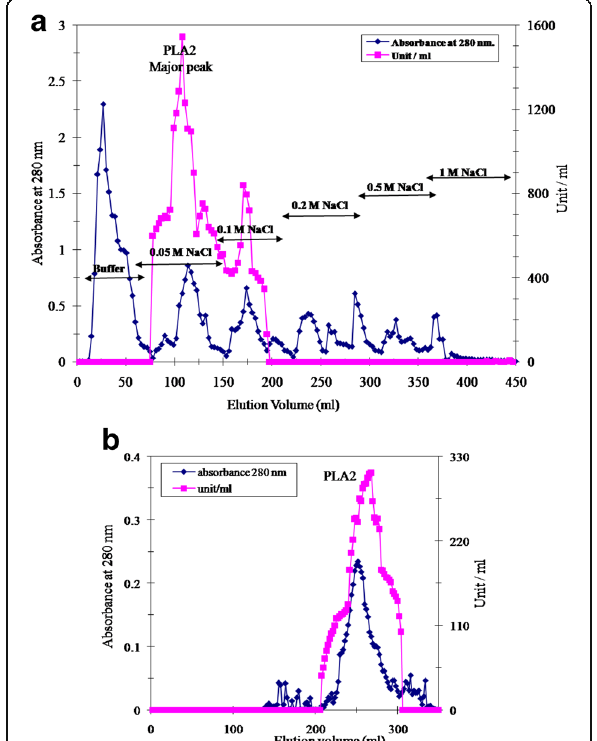
Fig. 1 a DEAE-cellulose column chromatography elution profile of crude honey bee venom. b Sephacryl S-300 column elution profile of the DEAE-cellulose concentrates containing PLA2